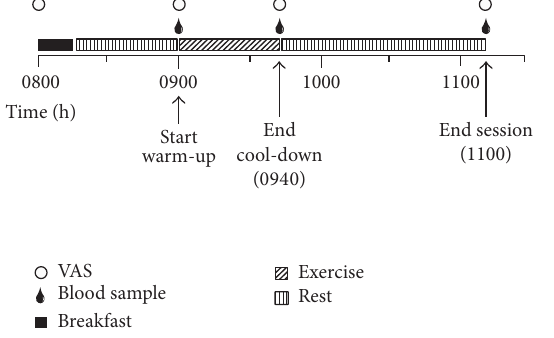
Figure 1: Overview of experimental session. VAS: visual analogue